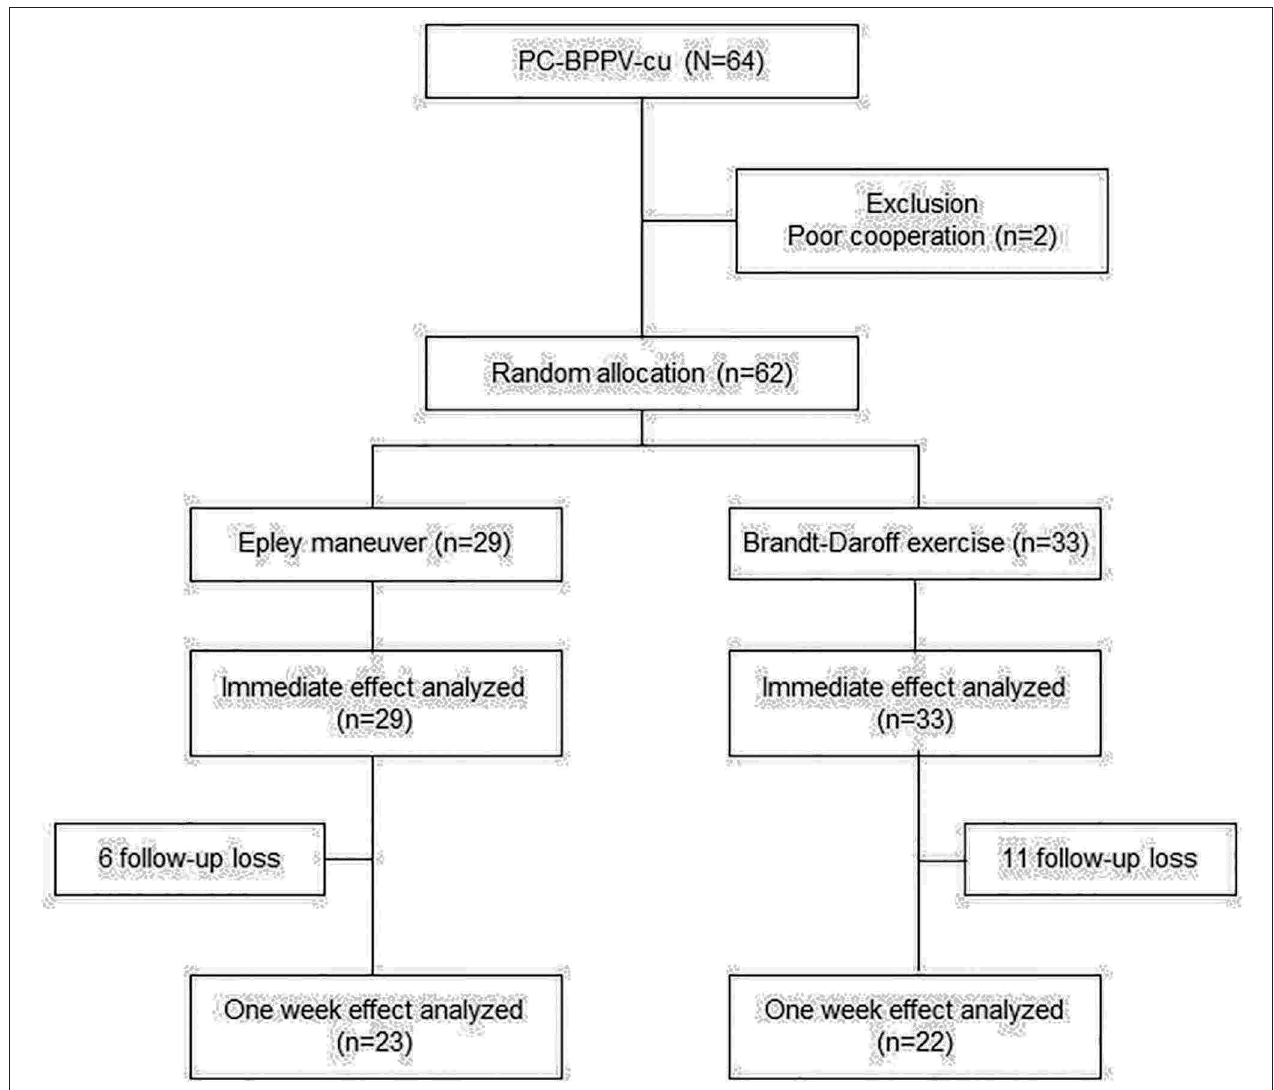
FIGURE 1 | Consort